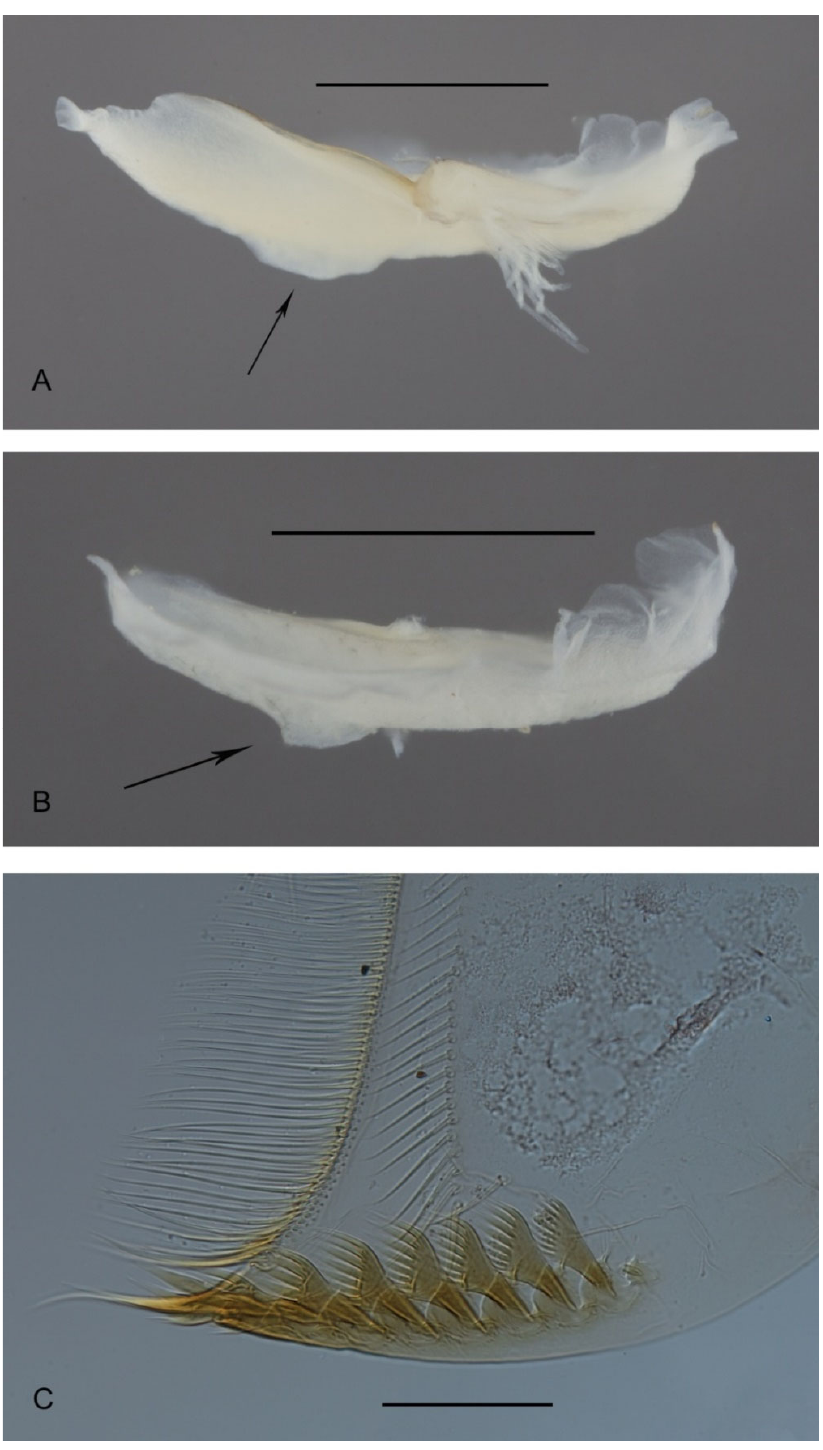
Figure 5. Rhithrogena spp. Latero ‐ dorsal view of the first gill to emphasize the shape of the plica (arrow) in Rh. insularis ( A ) and Rh. sartorii ( B ), Scale bar: 1mm. Crown of the galea ‐ lacinia of Rh. (arrow) in Rh. insularis ( A ) and Rh. sartorii ( B ), Scale bar: 1 mm. Crown of the galea-lacinia of Rh. sartorii ( C ). Scale bar 0.1 mm. sartorii ( C ). Scale bar 0.1